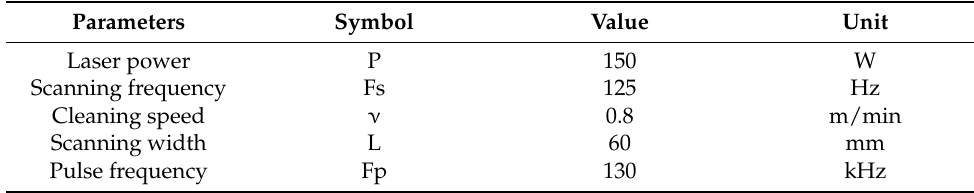
Table 2. Main parameters of laser cleaning after